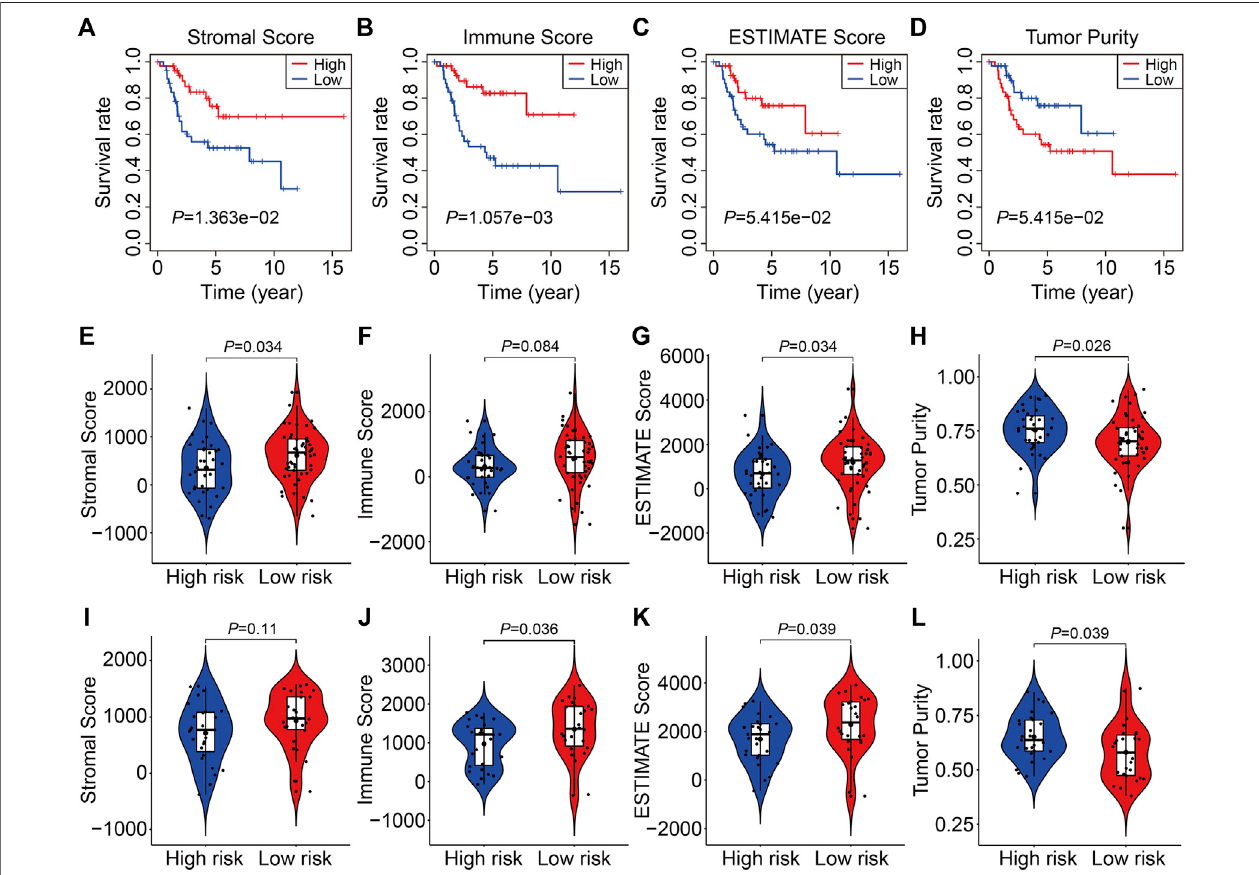
FIGURE 8 | The four SLC gene signature was correlated with tumor immune microenvironment. (A – D) Kaplan-Meier survival analysis was utilized to compare the overallsurvivalinpatientswithdifferentstromal,immune,andESTIMATEscore,andtumorpurity. (E – H) Thestromal,immune,andESTIMATEscore,andtumorpurityin high- and low-risk groups of the TCGA entire cohort. (I – L) The stromal, immune, and ESTIMATE score, and tumor purity in high- and low-risk groups of the GSE21257